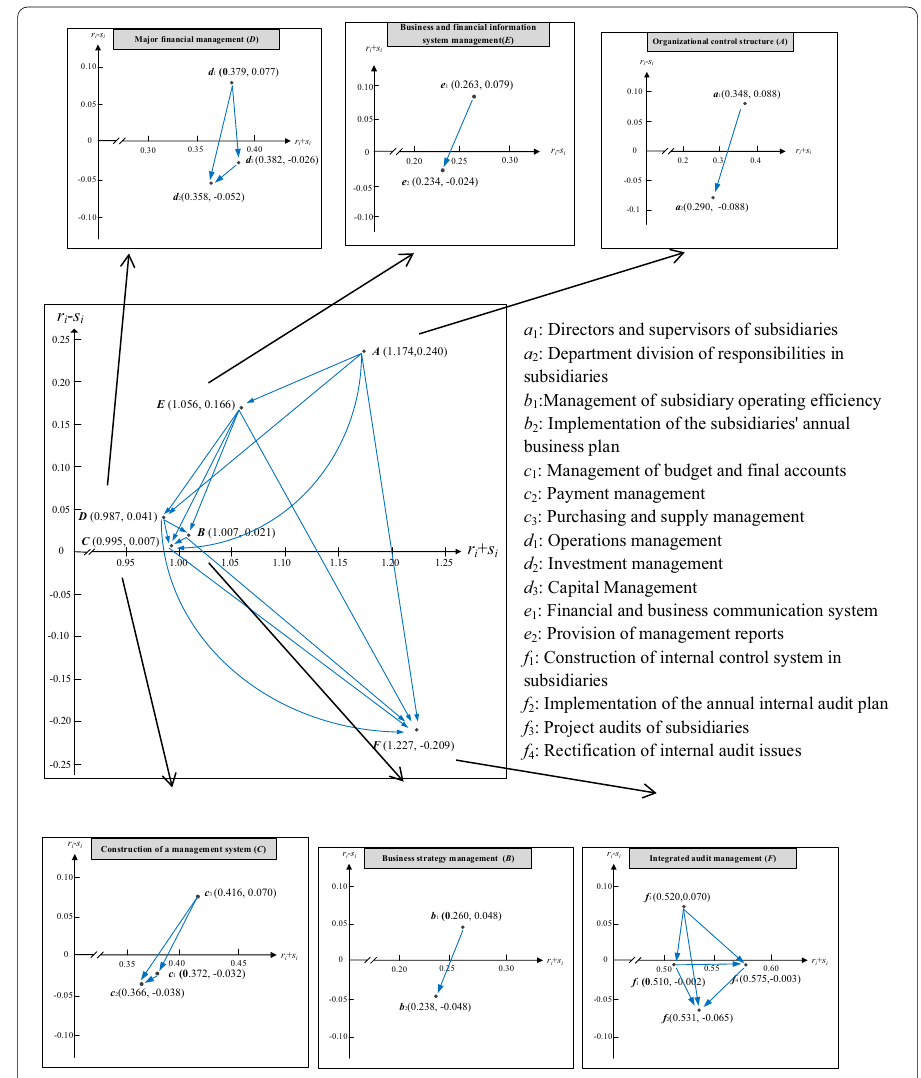
Fig. 4 The IINRM of influence relationships based on DEMATEL within supervision and management of framework using the DEMATEL method, as shown in Fig. 4. The horizontal axis r i + s i and the vertical axis r i − s i represent the degree of a relationship between cri- teria and the degree of causality between variables, respectively. IINRM enables us to clearly recognize the interdependence of various criteria in the parent-subsidiary